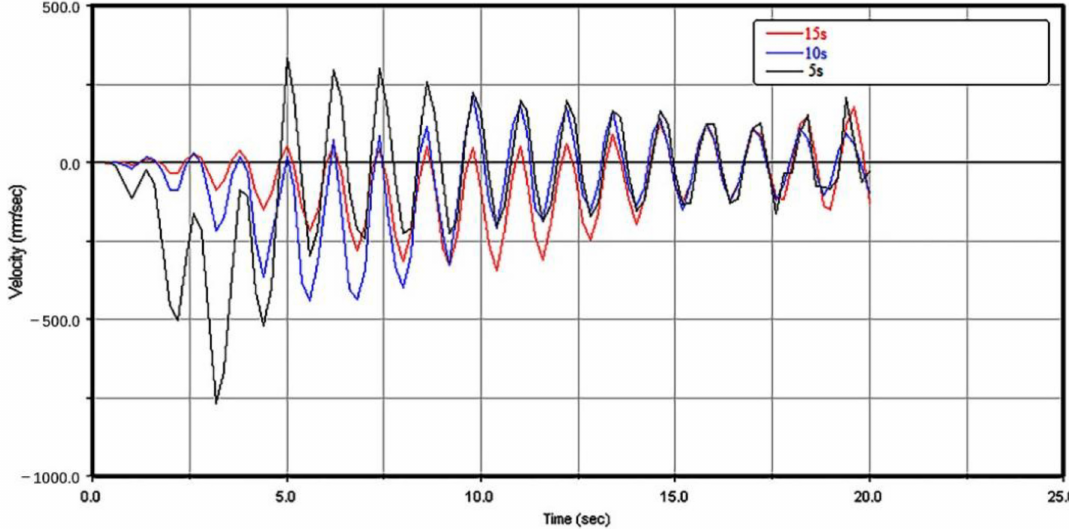
Figure 12. End speed distribution at different lifting